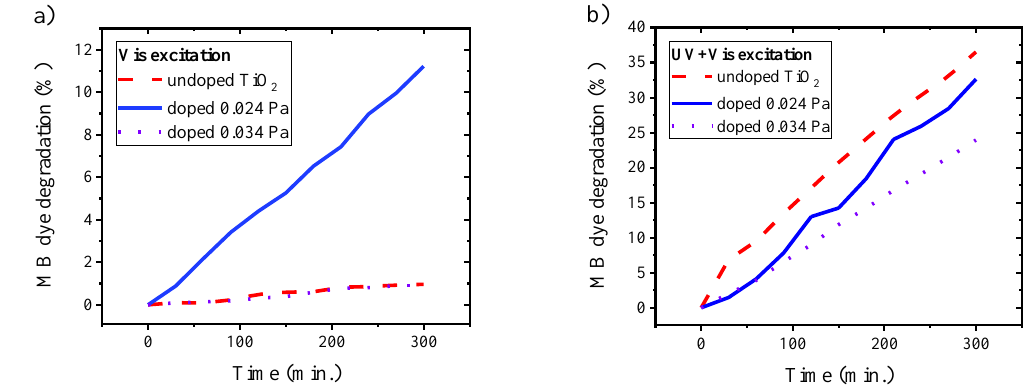
Figure 7. Degradation kinetics of methylene blue (MB) dye as a function of irradiation time in the presence of Bi/Bi 2 O 3 templates with undoped TiO 2 and N-doped TiO 2 overlayers, for two different N 2 partial pressures during deposition, upon excitation with ( a ) visible light (>400 nm) and ( b ) UV plus visible light irradiation (>365 nm).